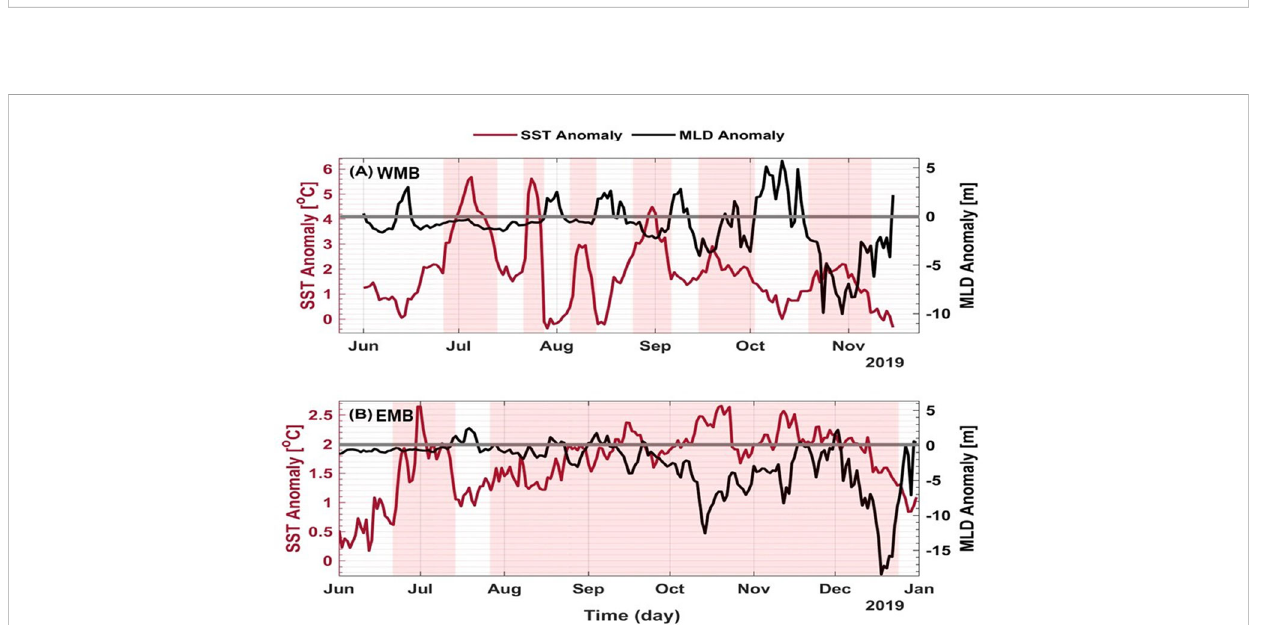
FIGURE 12 Time series of SSTA (red line) and mixed layer depth anomaly (black line) for (A) the WMB and (B) the EMB between June and December 2019. The red shaded areas represent the MHW